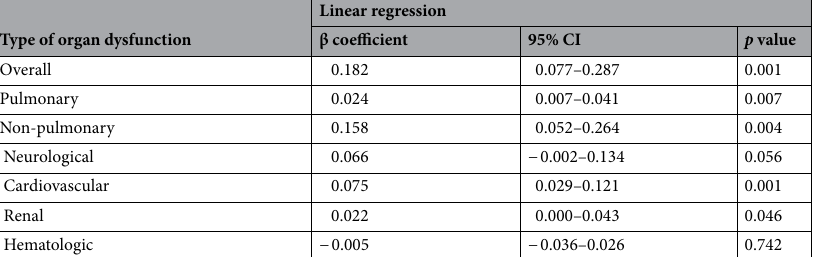
Table 2. Multivariate regression analysis of the association between P50 and the type of organ dysfunction. Analyses were adjusted for age, sex, weight, comorbidities, and initial PALICC grade. β coefficients were depicted for each mmHg increment of P50. CI Confidence interval, PALICC Pediatric acute lung injury consensus conference.